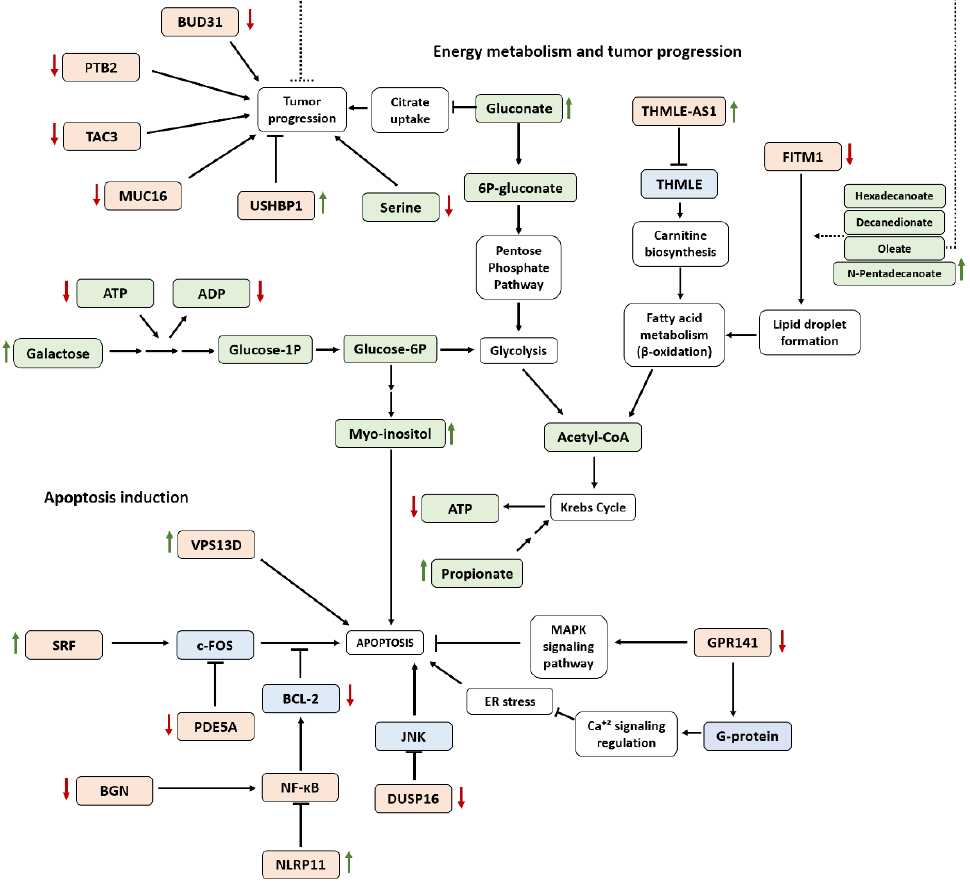
Figure 5. Proposed scheme of the biomolecular mechanisms associated with the anti-tumoral effect induced by the treatment with RhNPs and NIR irradiation provided by both genomic and metabolomics experiments. Colors indicate proteins (blue), genes (pink), metabolites (green) or cellular processes (white).